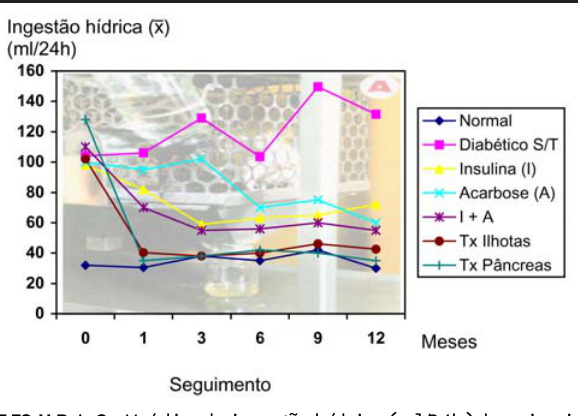
FIGURA 3 - Médias da ingestão hídrica (ml/24h) de animais normais, diabéticos não tratados e diabéticos tratados com cinco diferentes tratamentos, durante 12 meses de seguimento.